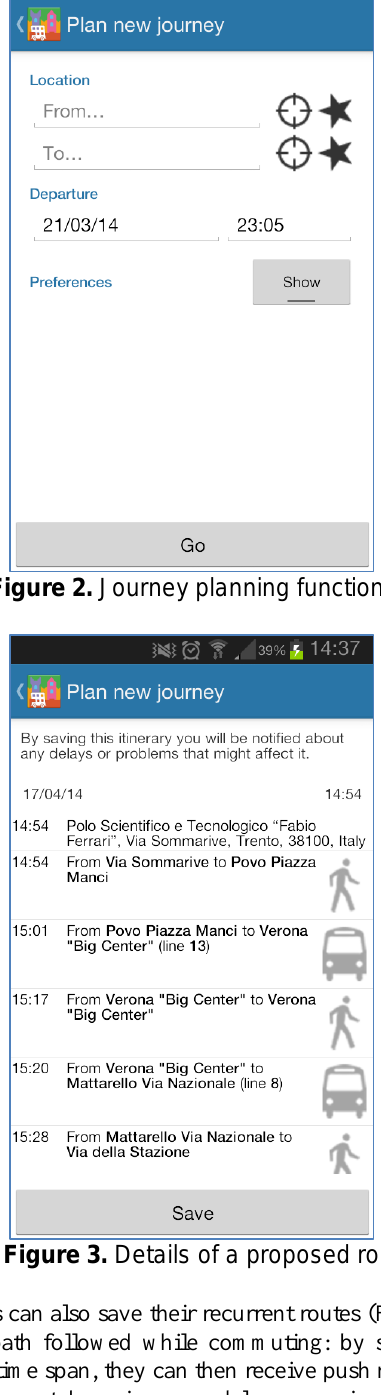
Figure 1. Home page of the ViaggiaTrento app